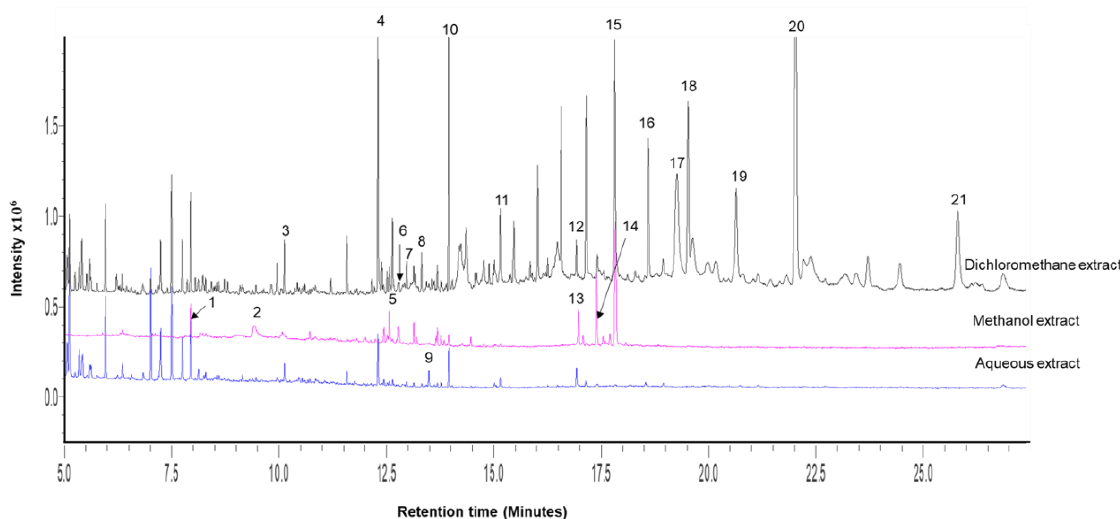
Figure 1. Representative total ion chromatograph (TIC) of Melianthus comosus (aqueous, methanol and dichloromethane) extracts. All peaks correspond to the data presented in Table 1. Table 1. GC-MS spectral analysis of Melianthus comosus (aqueous, methanol and dichloromethane) extracts. Ret. Time Peak #